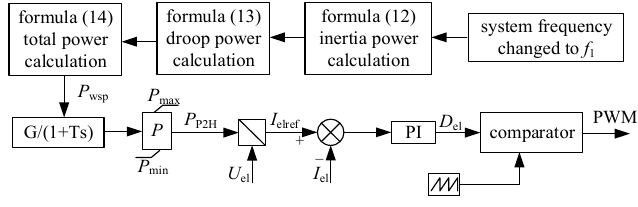
Figure 6. The control diagram of P2H.